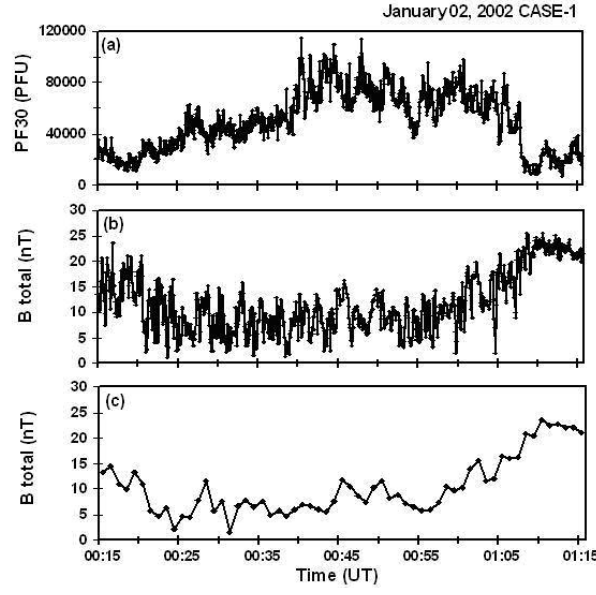
Fig. 5. Plot of the expanded time interval for Burst 1 in Case